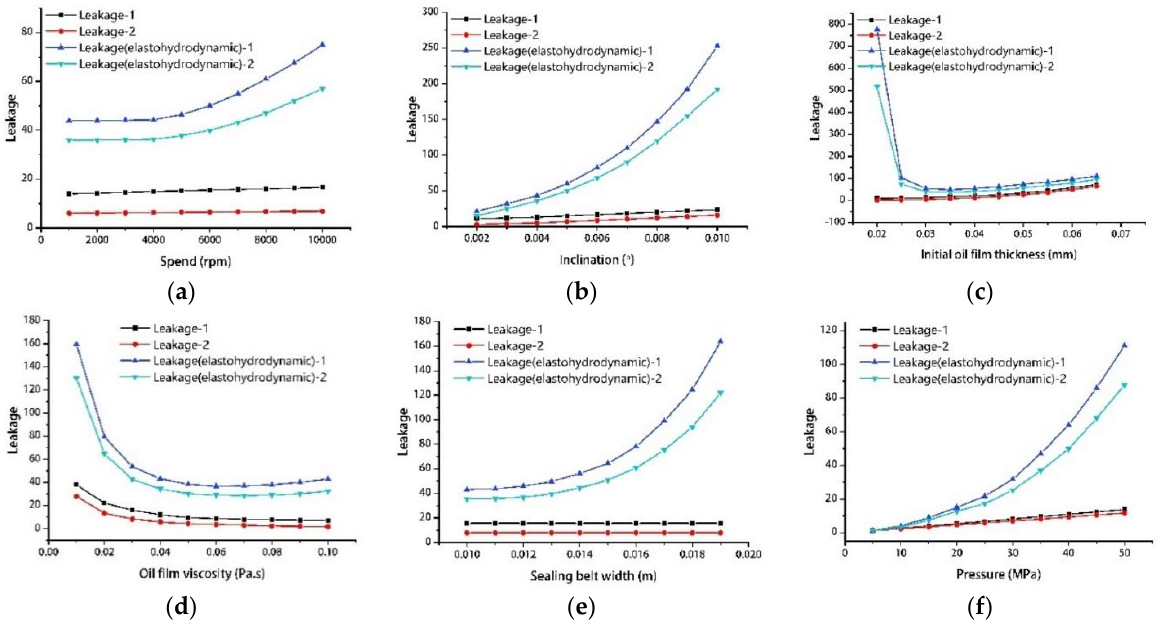
Figure 19. The effect of the different working conditions on the leakage quantity. ( a ) Velocity; ( b ) angle of inclination; ( c ) initial oil film thickness; ( d ) viscosity; ( e ) sealing belt width; ( f ) inlet pressure.